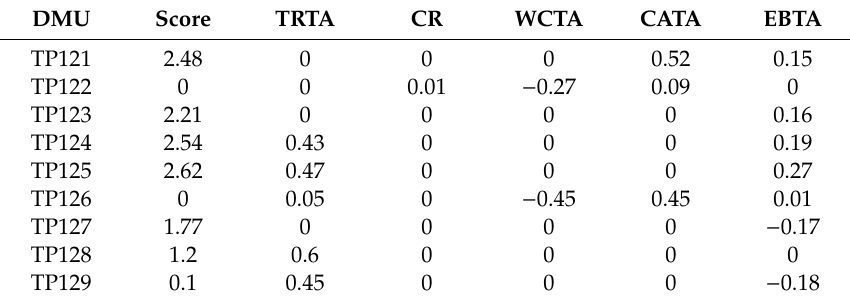
Table 2. Selected results of the Additive DEA model (ADD model).